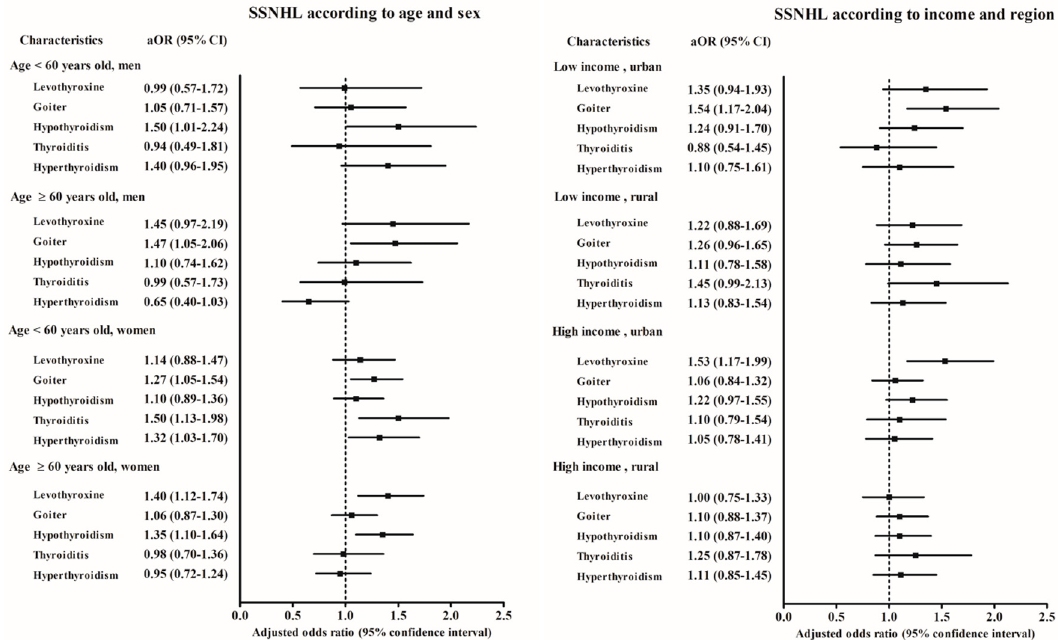
Figure 2. Odds ratios (95% confidence interval) of levothyroxine medication, goiter, hypothyroidism, thyroiditis, and hyperthyroidism for sudden sensorineural hearing loss according to age and sex and income and region of residence.